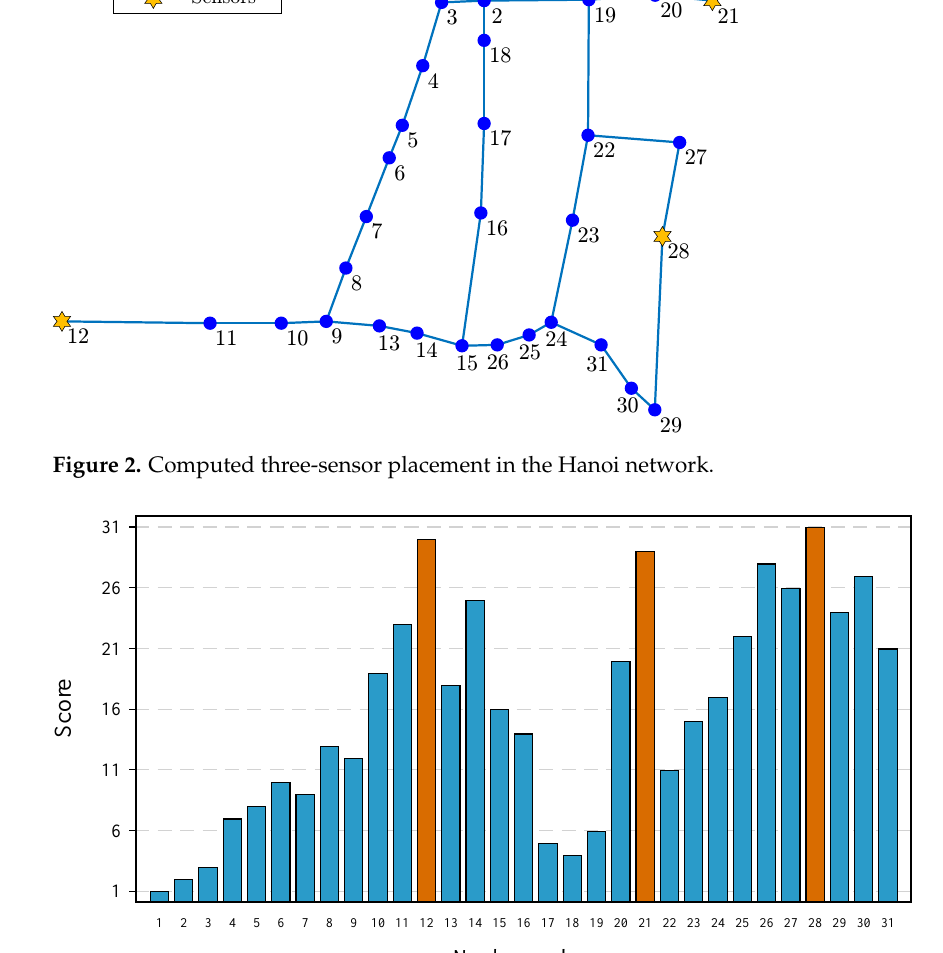
Figure 3. Node ranking in the Hanoi